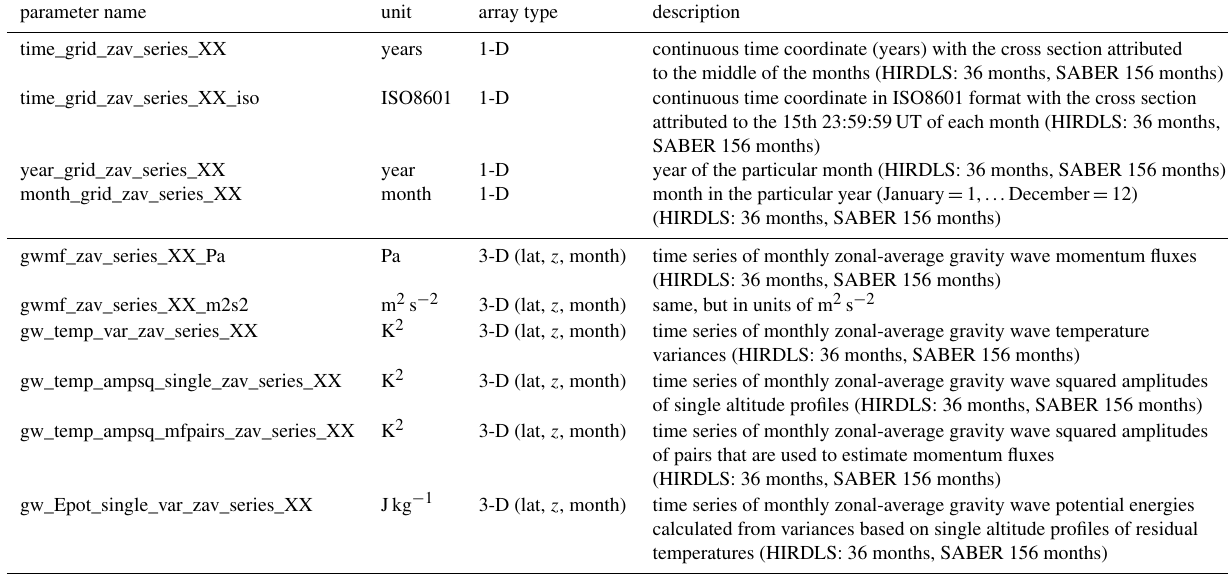
Table 5. Time series of gravity wave parameter zonal-average cross sections provided in the GRACILE gravity wave climatology data file. In the parameter names “XX” is to be replaced by either “SABER” or “HIRDLS”. Grid points not covered by data are flagged with − 999. The latitude–altitude grid is the same as for the parameters listed in Table